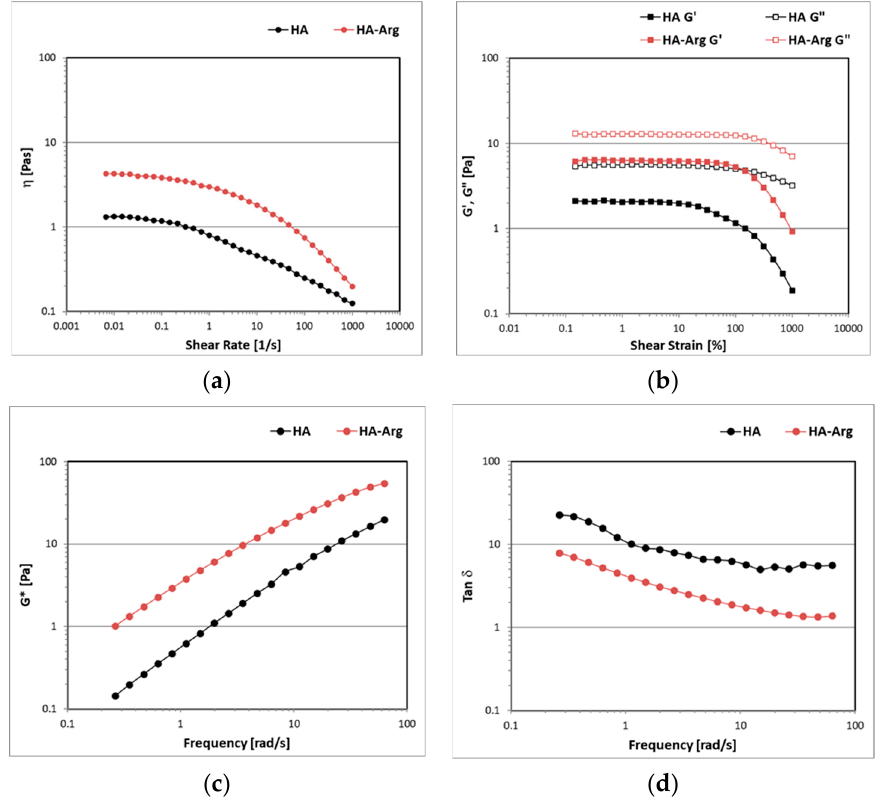
Figure 6. The trend of viscosity values ( panel a ), G ′ and G ″ moduli ( panel b ), complex moduli (G*) ( panel c ), and damping factor (tan δ ) ( panel d ).